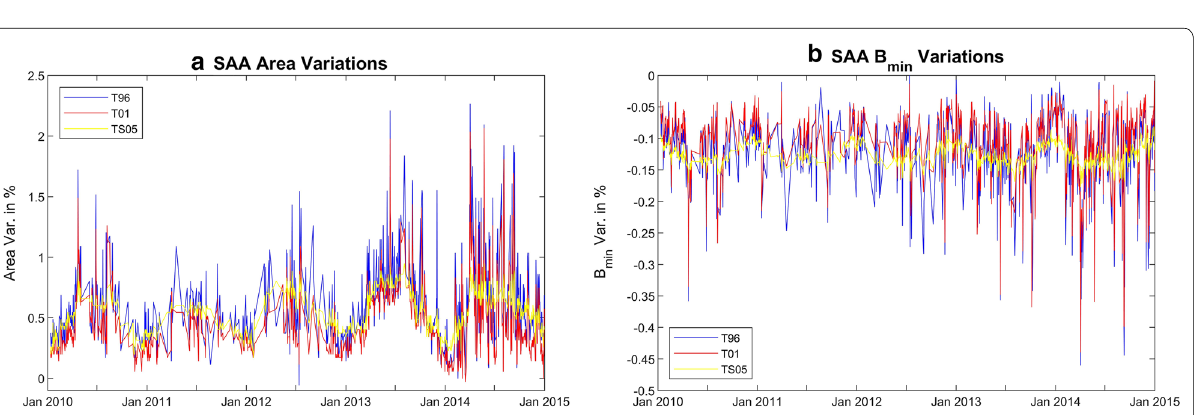
Fig. 3 Temporal variations of the two SAA variables. a represents the area and b the B min , by adopting the Tsyganenko models T96, T01, and TS05, at an altitude of 800